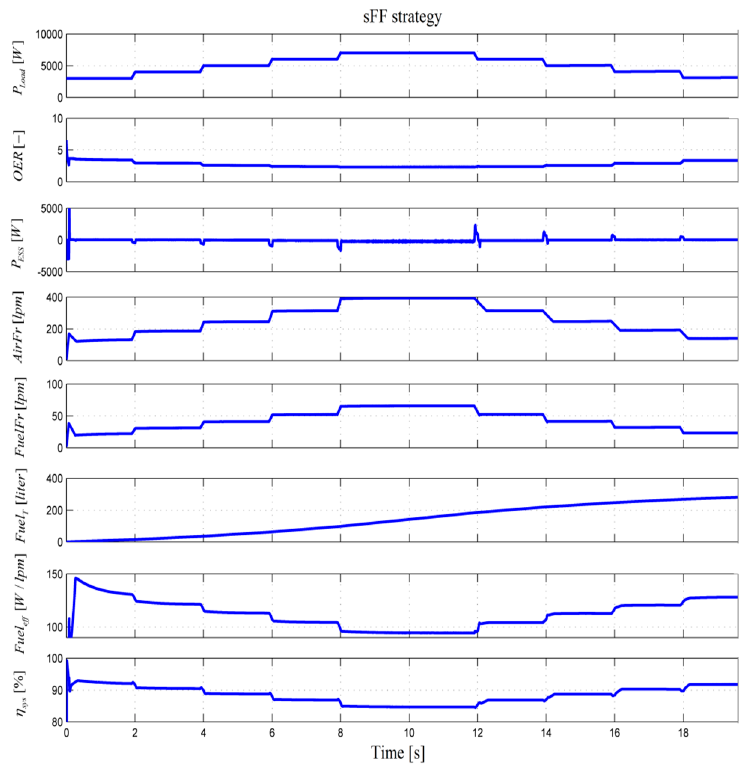
Figure 4. FC system behavior using static feed-forward (sFF) strategy. Appl. Sci. 2020 , 10 , x FOR PEER REVIEW